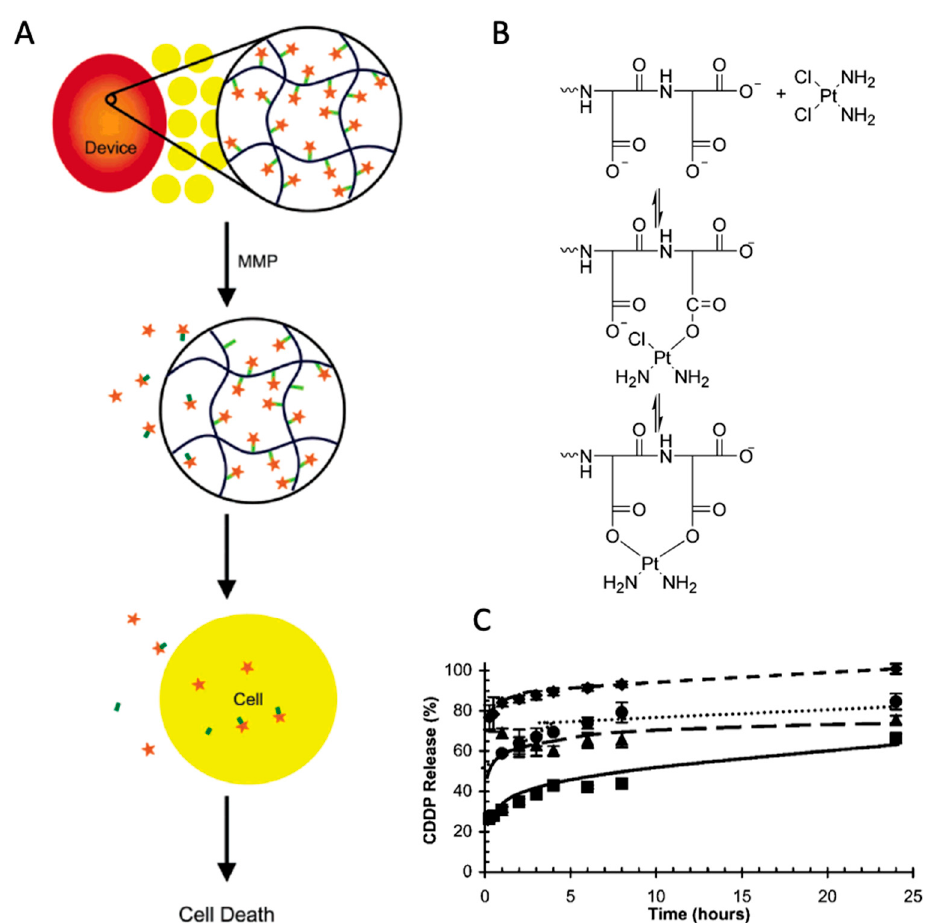
Figure 10. Schematic of cancer chemotherapeutic hydrogel matrixes ( a ) obtained through the complexation of platinum and aspartic acid linked to peptides in the network ( b ) and their release from hydrogel matrixes ( c ) [42] (Reproduced from [42] with permission. Copyright 2005 American Chemical Society). MMP: matrix metalloprotein. CDDP: cisplatin.